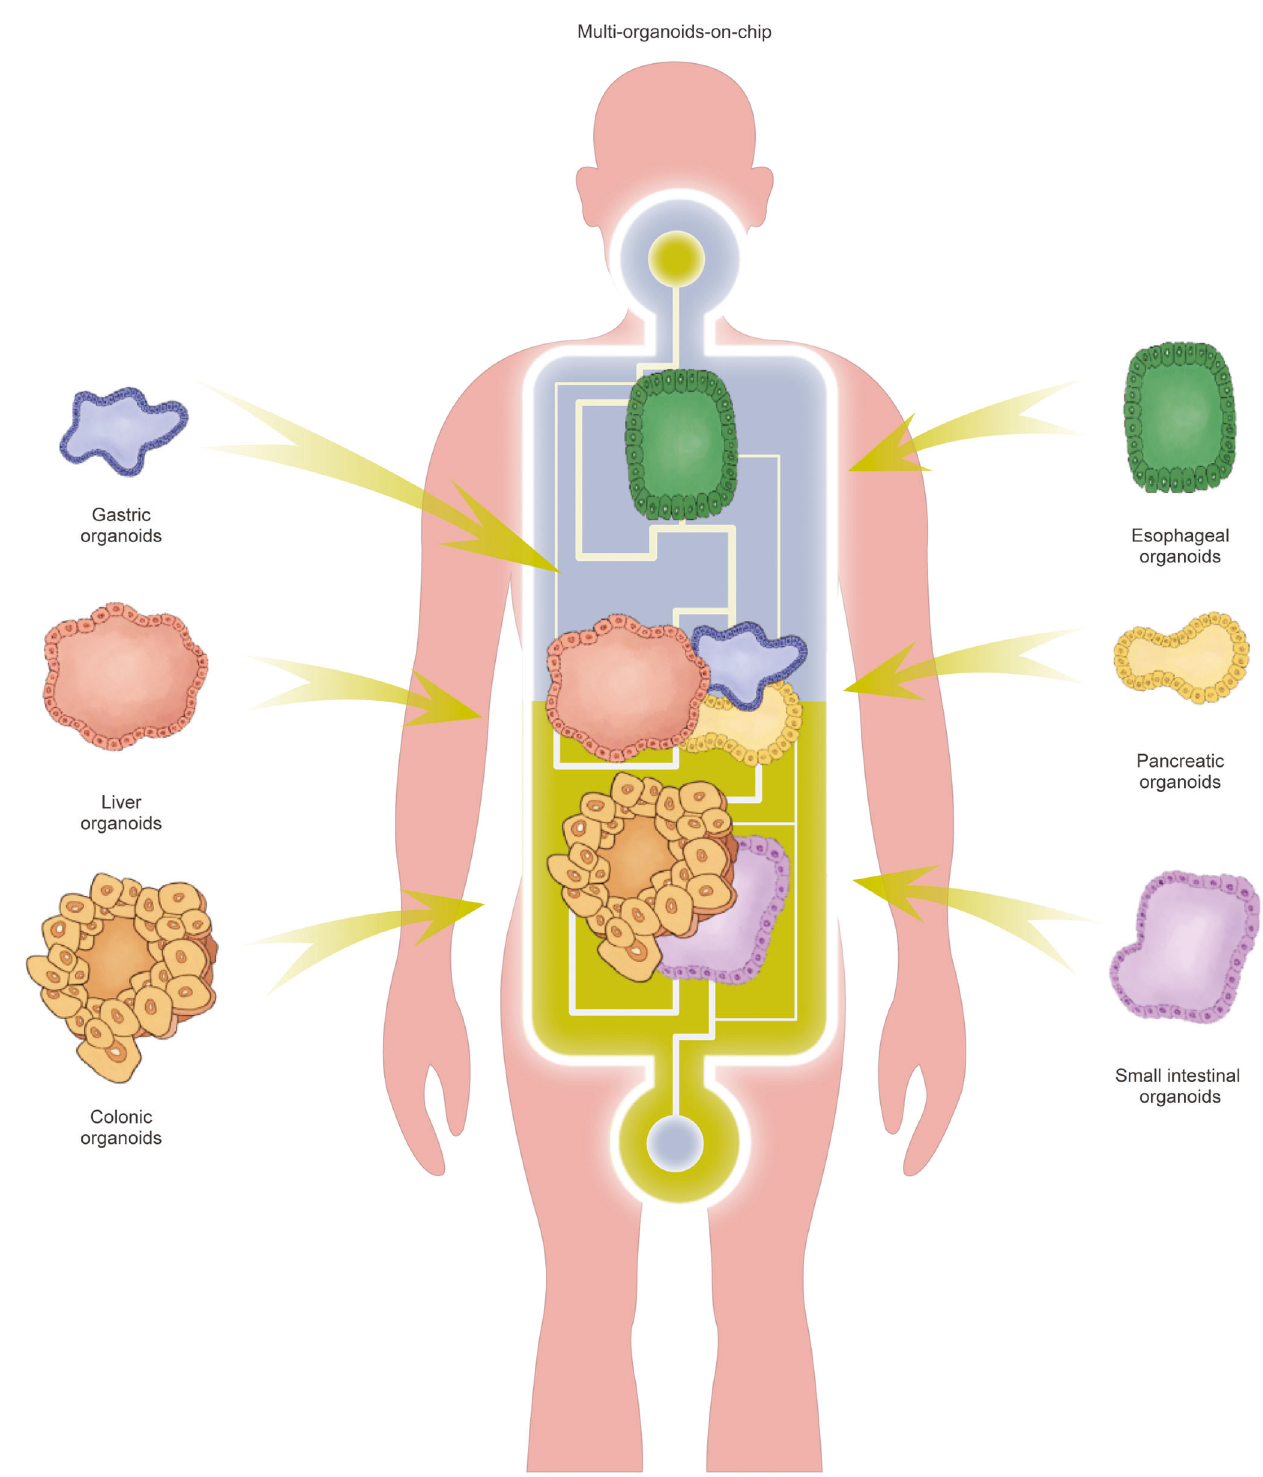
Fig. 5 Future trends in the development of multi-organoid models. Organoids of the esophagus, pancreas, stomach, and intestines can be generated in vitro and combined to form a multi-organoid model on a microarray to test multiorgan diseases and cancer metastasis as well as drug toxicity and ef fi cacy (scRNA-seq) methods have changed the paradigm of biomedical doors for understanding the role of speci fi c genes in human science by analyzing cellular heterogeneity from multivariate digestive system disease. 139,512 – 514 The distribution and function data. 516 scRNA-seq of organoids has allowed certain rare or of target genes during digestive development or progression of disease can be detected in real time by gene knockin abnormal cell types to be identi fi ed, and these fi ndings can be fl uorescent labeling in iPSCs. 514,515 Single-cell RNA sequencing detected in individual organoids. 98,517 By deepening the Signal Transduction and Targeted Therapy (2022)